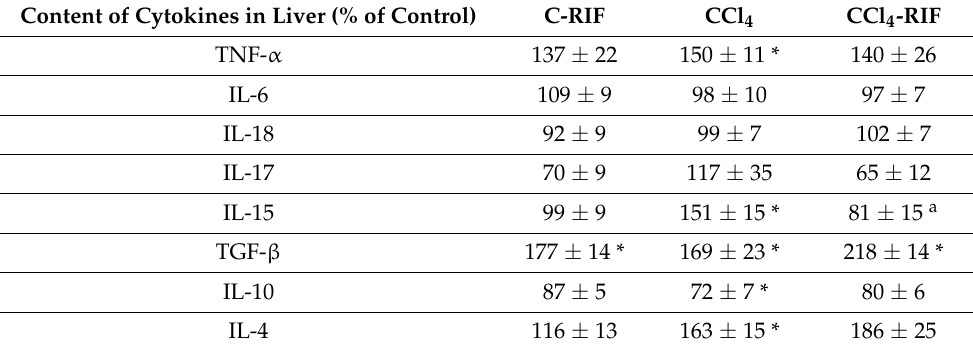
Table 1. Liver inflammation: content of cytokines. Changes in liver cytokines at 4 weeks of treatment with CCl 4. The levels of all cytokines was analyzed by western blot. Data are the mean ± SEM of the indicated number of rats and are given as percentage of control rats. Six rats per group were used for this analysis. One-way ANOVA and Bonferroni’s or Dunnett’s tests for multiple comparisons were performed. Values significantly different from control rats are indicated by asterisks, * p < 0.05; statistical differences between CCl 4 and CCl 4 -RIF are indicated by “a”, p < 0.05. Representative bands of liver cytokines western blots are shown in Figure